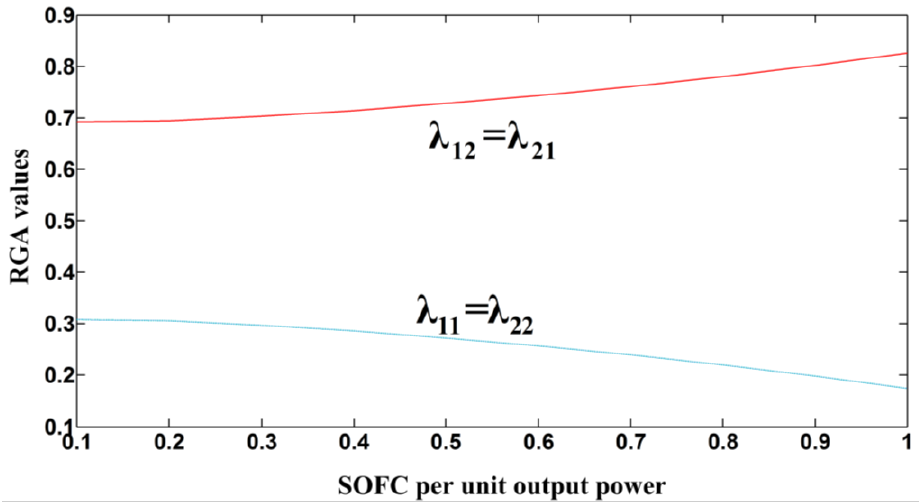
Figure 5. Variations of the values of Λ elements with P